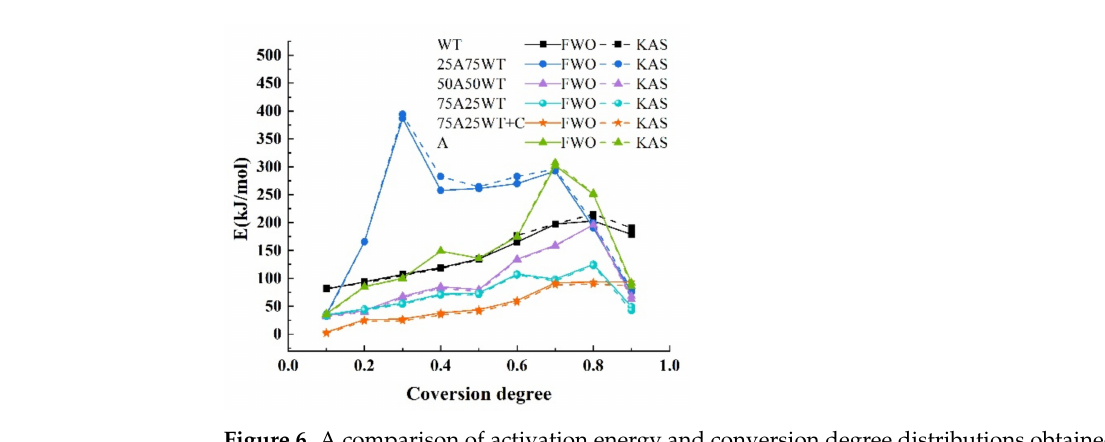
Figure 6. A comparison of activation energy and conversion degree distributions obtained by FWO and KSA for AP, WTS, and their blends.